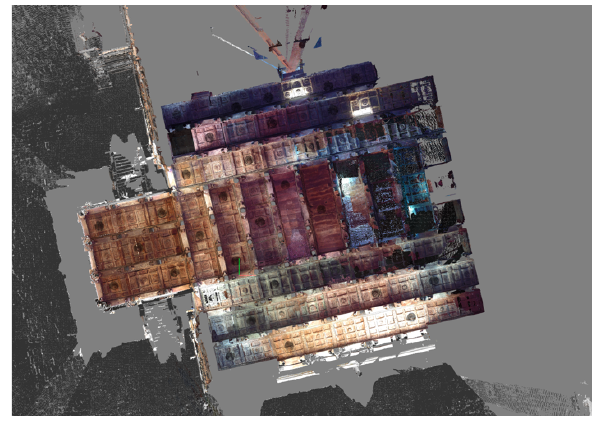
Figure 7. Reflected ceiling plan of Airavateshvarar Temple, Darasuram